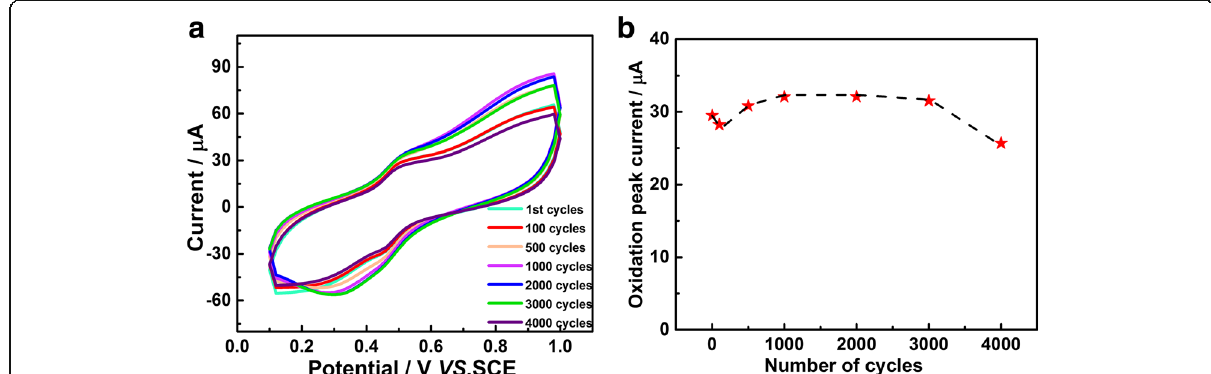
Fig. 4 a The CVs of the 0.48 μ g PtNi/C electrode in 0.5 mM CA after various numbers of potential cycles at a scan rate of 100 mV s − 1 . b The oxidation peak current vs number of